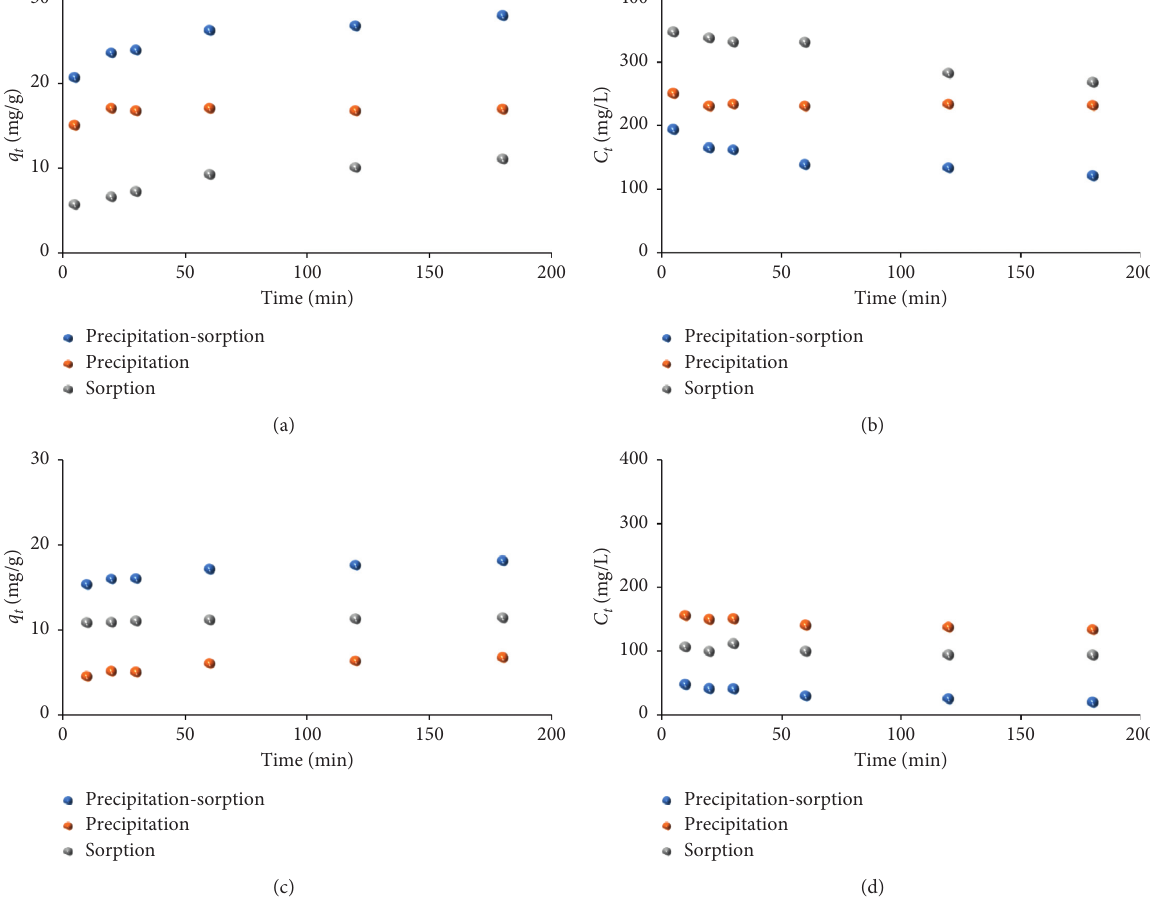
Figure 1: Variation of uptake capacities and remaining concentrations versus time for total sorption, sorption, and precipitation mechanisms at different values of initial nickel metal concentrations. (a) C o � 400mg/L. (b) C o � 400mg/L. (c) C o � 200mg/L. (d) C o �